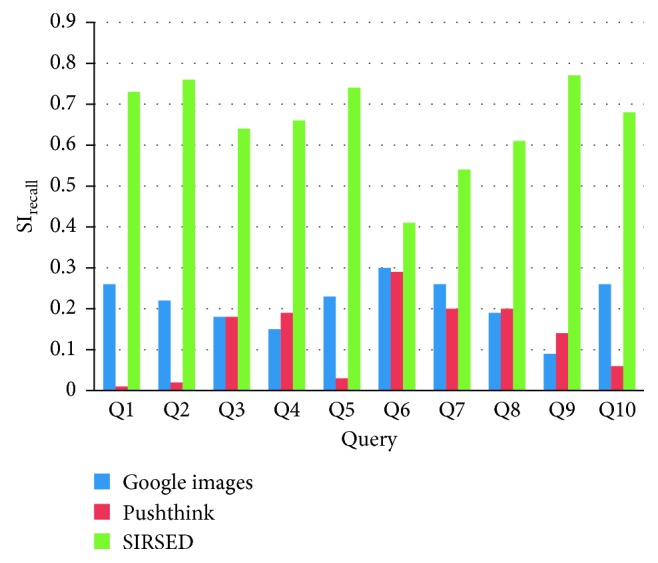
SIrecall comparison.